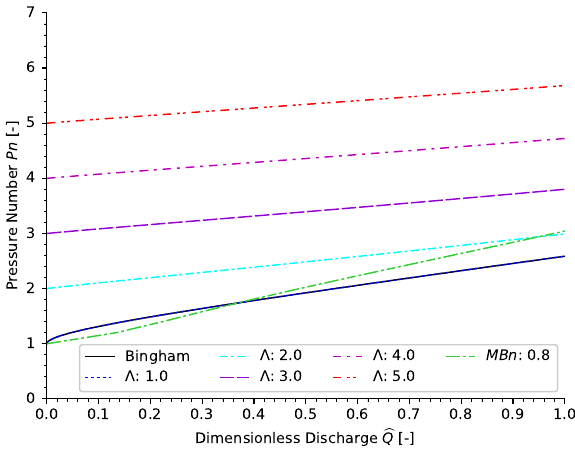
Figure 8: The discharge diagram becomes non-linear for a Bingham fluid for pressure numbers smaller than ca. 1.5 , where lower order terms in the Buckingham-Reiner equation are no longer